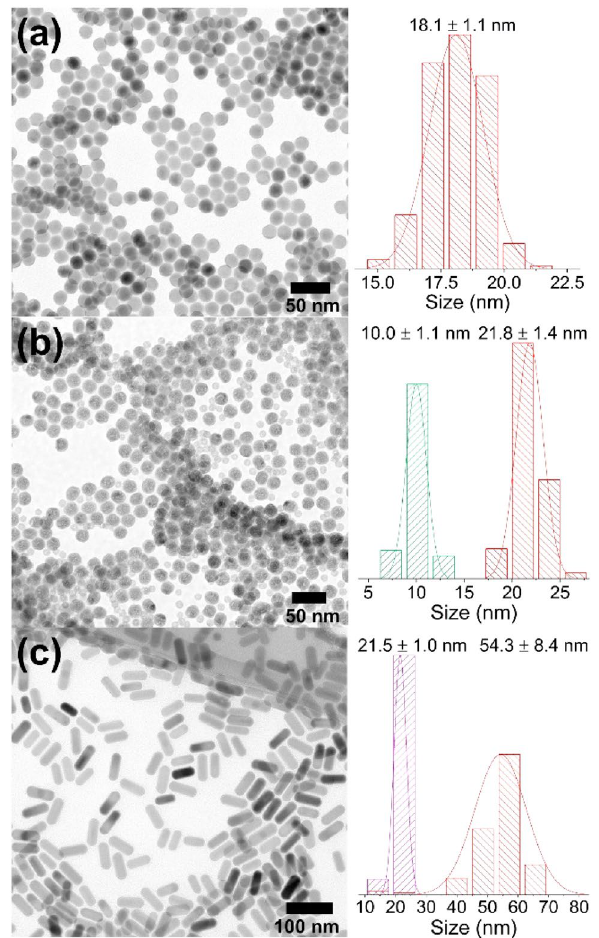
Figure 2. TEM images with NPs size distribution for ( a ) NaErF 4 :Tm 3+ core UCNPs, ( b ) NaErF 4 :Tm 3+ @NaYF 4 _I NPs, and ( c )